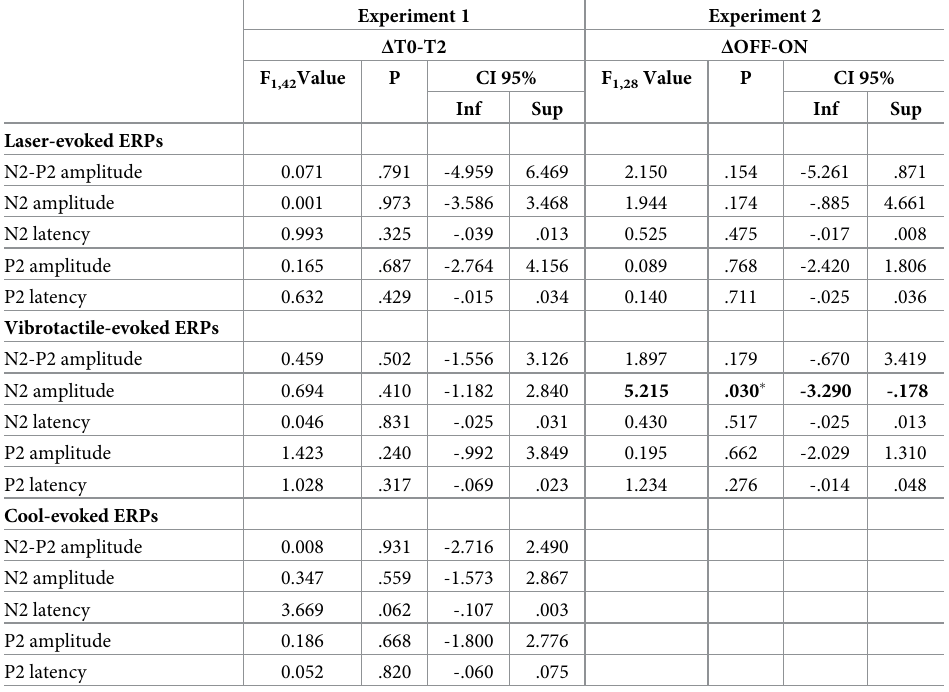
Table 7. Linear mixed models with within-subjects factors ‘condition’: Δ Cerebral responses (Experiment